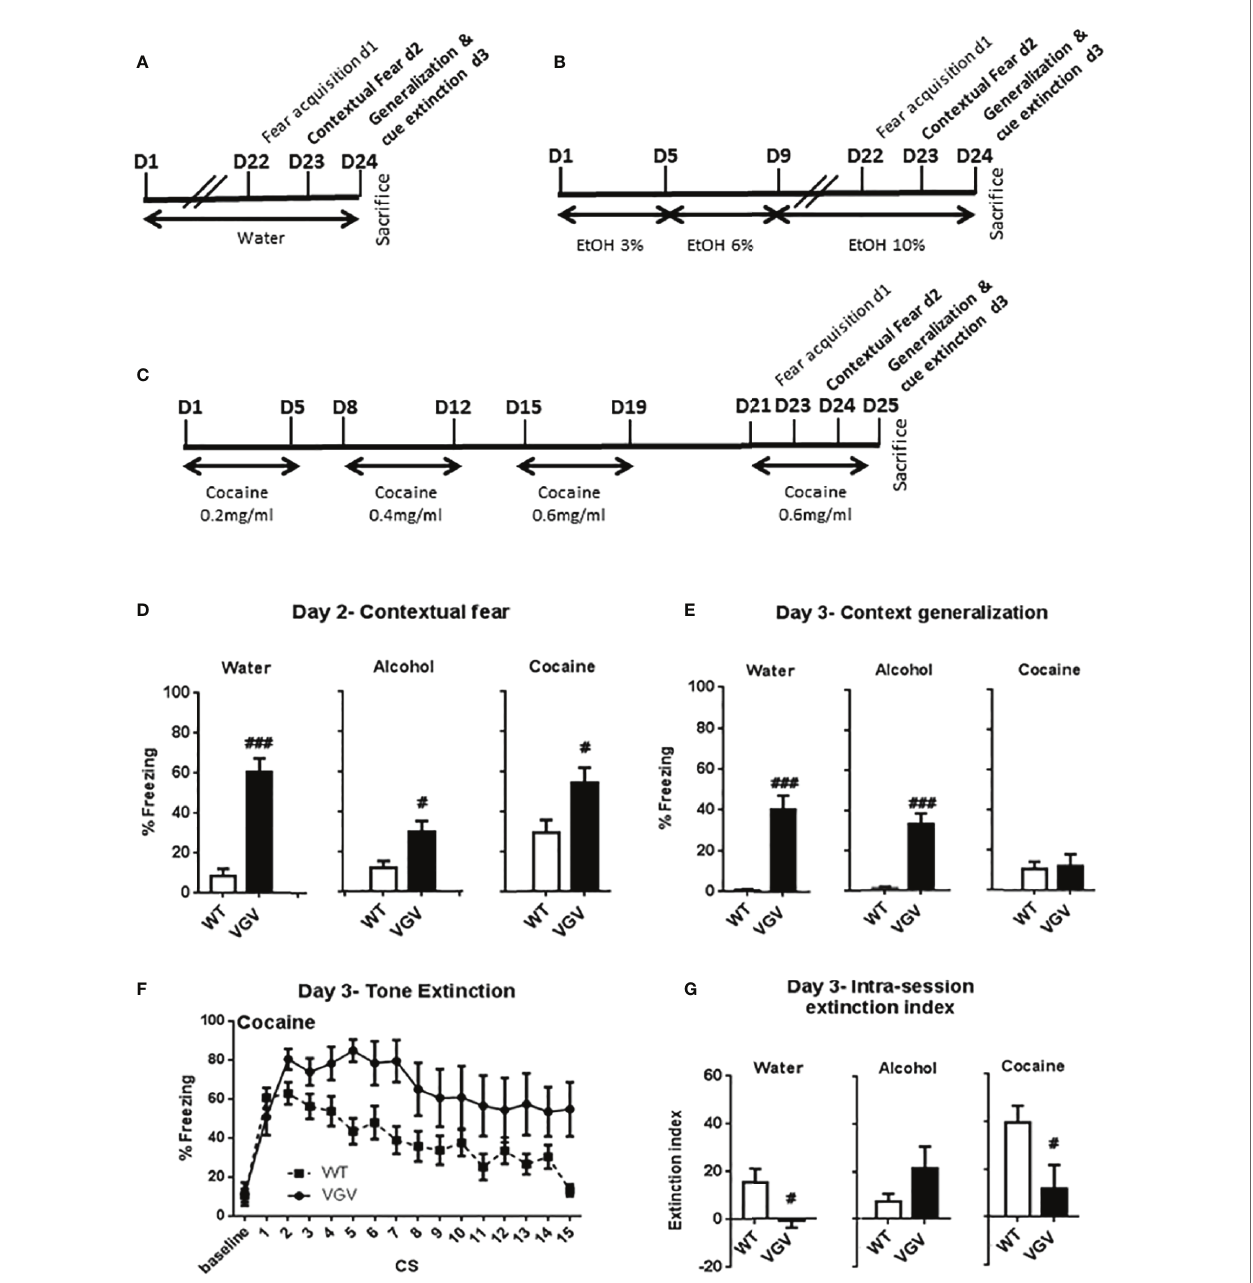
FIGURE 3 | Both self-administered chronic alcohol and cocaine altered fear behaviors in VGV mice (A – C) Protocol of water, alcohol or cocaine intake before and during the conditioned fear testing period. (D) During the contextual fear test VGV mice presented higher freezing than WT mice [ t (19) = 6.27, p < 0.001, t (23) = 2.65, p < 0.007, t (18) = 2.53, p = 0.011, for water (WT, n = 10, VGV, n = 11) alcohol (WT, n = 12, VGV, n = 13) and cocaine (WT, n = 12, VGV, n = 8), respectively] (E) Water- and alcohol-treated VGV mice displayed higher fear generalization during the baseline period of the tone session [ t (23) = 6.06, p < 0.001, t (30) = 6.19, p < 0.001, respectively], but not cocaine-treated mice compared to similarly treated WT mice. In addition, in the cocaine condition there was a small amount of fear generalization in WT animals (one sample t-test compared to 0; t 11 = 3.06; p < 0.05). (F) Curve extinction pro fi le of WT and VGV mice treated with cocaine. A two- way ANOVA analysis between WT and VGV cocaine-treated mice revealed a genotype effect [F(1,18) = 8.15, p <0.05], an effect of time [F(14,252) = 5.92, p <0.001] and an interaction CS × genotype [F(14,252) = 1.80, p <0.05]. (G) Water- and cocaine-treated VGV mice showed reduced fear extinction index (de fi ned as [mean freezing at CS1 and CS2] − [mean freezing at CS14 and 15]) compared to similarly treated WT mice [water: t (23) = 2.52, p = 0.0096; cocaine: t (18) = 2.37, p = 0.0014], but VGV mice were not different from WT mice in the alcohol treatment condition. Data are expressed as mean ± S.E.M. VGV vs WT mice (water-treated WT, n = 13, or VGV mice, n = 12; alcohol-treated WT, n = 16, or VGV mice, n = 16; cocaine-treated WT mice, n = 8; cocaine-treated VGV mice, n = 12; # p < 0.05; ### p <